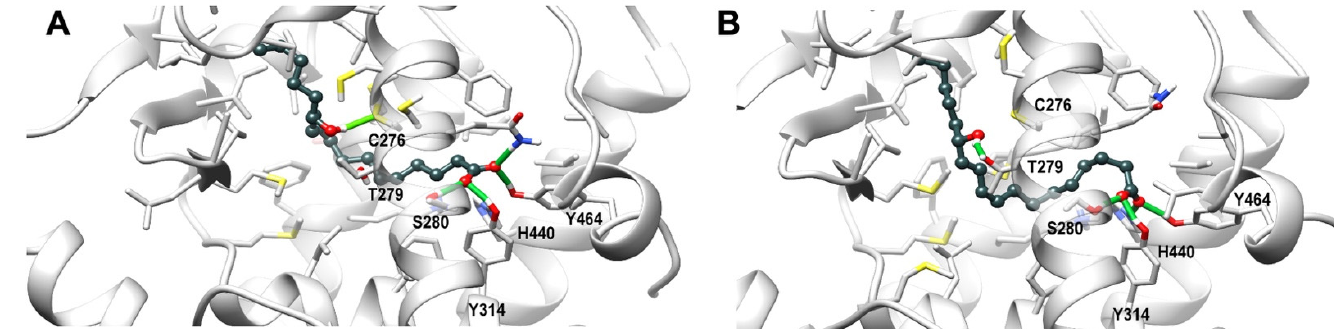
Figure 10. Impact of 13-HODE and 13-HODE-G on PPAR activity. Cells were incubated with 30 µM 13-HODE, 13-HODE- G, or OEA overnight and PPAR activity was measured using the PPAR assay kits according to the manufacturers’ instruc- tions. Rosiglitazone (10 µM) and GW 590735 (100 nM) were utilized as positive controls for the ( A ) PPAR- γ and ( B ) PPAR- Figure 11. Representative frames from molecular dynamics of PPAR α (light gray) in complex with 13-HODE (dark grey) α assays, respectively. Data represent the mean (± SEM) of three (PPAR- γ ) or five (PPAR- α ) experiments, each performed shown in ball and stick representation. Panel ( A ) and ( B ) show the docking pose I and pose II of the ligand, respectively. in triplicates. p values were obtained by performing a 2-way ANOVA with a Sidak multiple comparison tests. **** p < Protein residues within 5 Å from the ligands are shown in stick representation. H-bonds are shown as green stick. Hydro- 0.0001, *** p < 0.001. ns: p > 0.05 gen, nitrogen, oxygen, and sulfur atom are painted white, blue, red, and yellow, respectively. A transparent surface for ribbons was used wherever they hide the ligand-binding site.